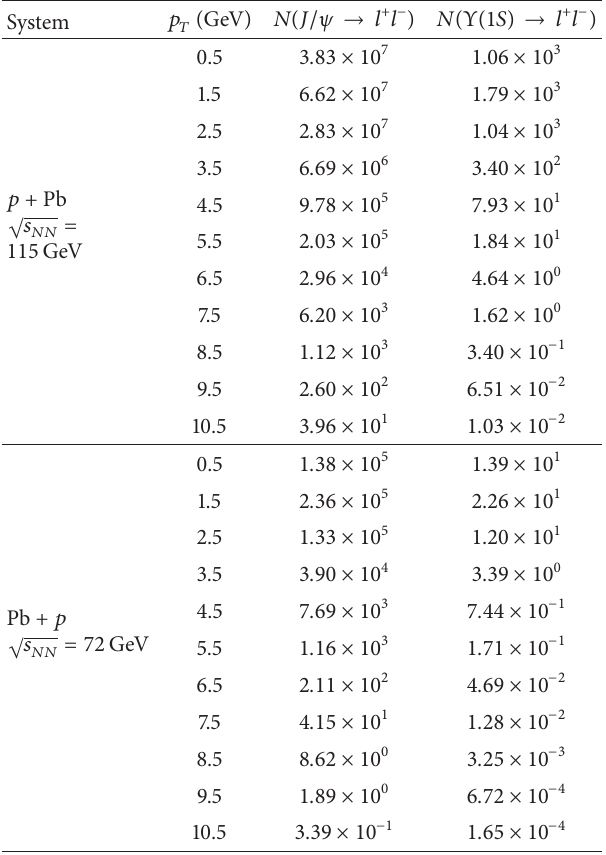
Table2:The 𝑝 𝑇 -dependentratesper1GeV 𝑝 𝑇 binfor 𝐽/𝜓 and Υ(1𝑆) in the two scenarios discussed in the text. The values are given for the EPS09 NLO central